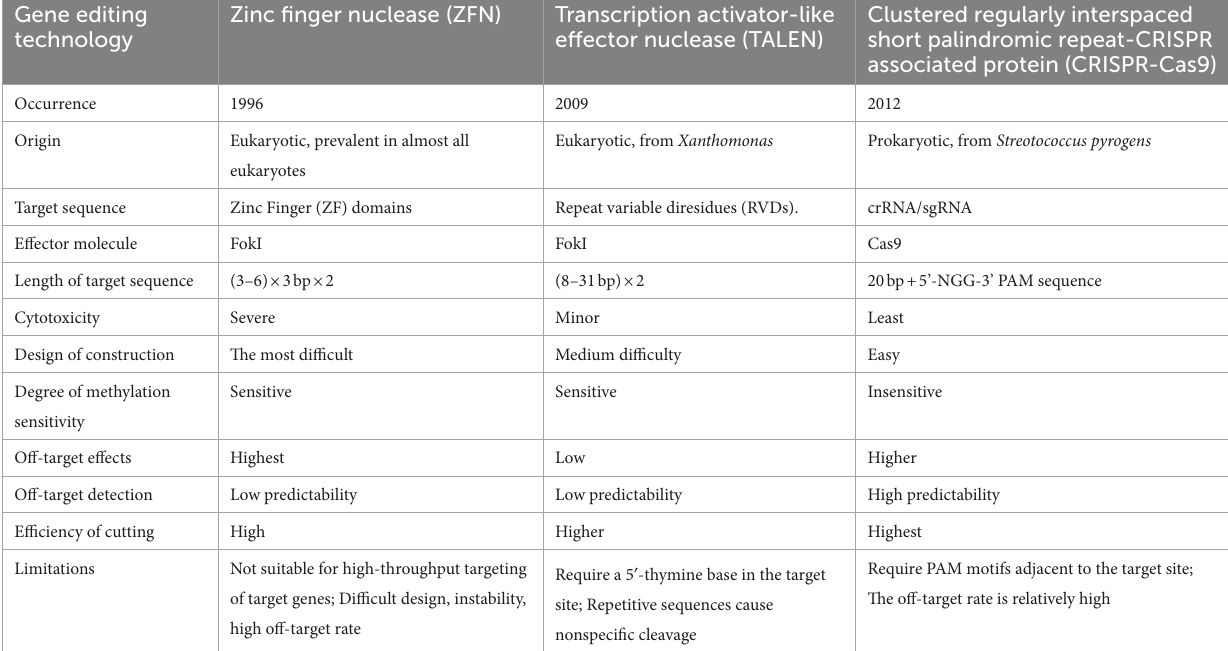
TABLE 1 Systematic comparison of nuclease-based gene editing technologies. Gene editing